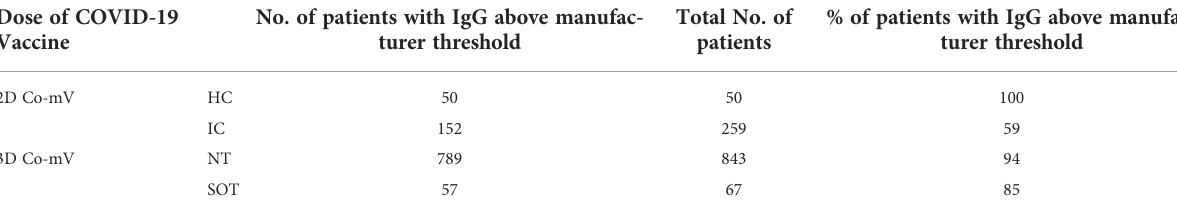
TABLE 2A Estimation of 2D and 3D COVID-19 vaccine administered IC cohorts exhibiting IgG titer above manufacturer recommended threshold of 50 AU/mL. Dose of COVID-19